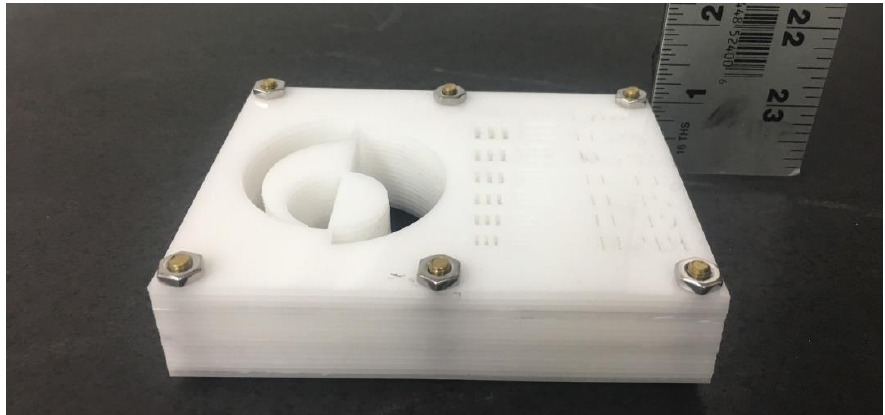
Figure 2. Imaging phantom object—125 mm × 98 mm × 25.4 mm.